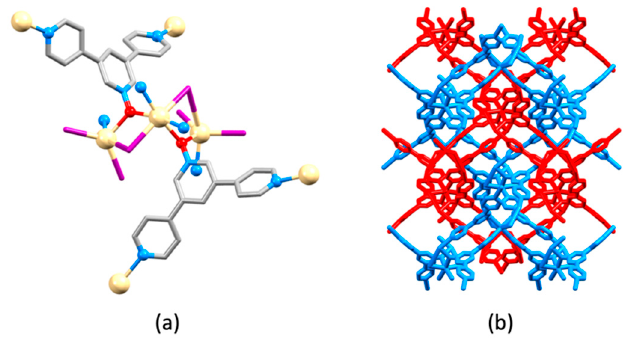
Figure 46. The structure of [Cd 3 I 6 ( 67 ) 2 ] n (CSD refcode HATFIU). ( a ) The building block in the 3D-assembly showing the {Cd 3 I 4 ( µ -I) 2 ( µ -O) 2 N 4 } unit, and ( b ) part of the 2-fold interpenetrating 3D network view down the crystallographic a -axis (terminal I atoms are